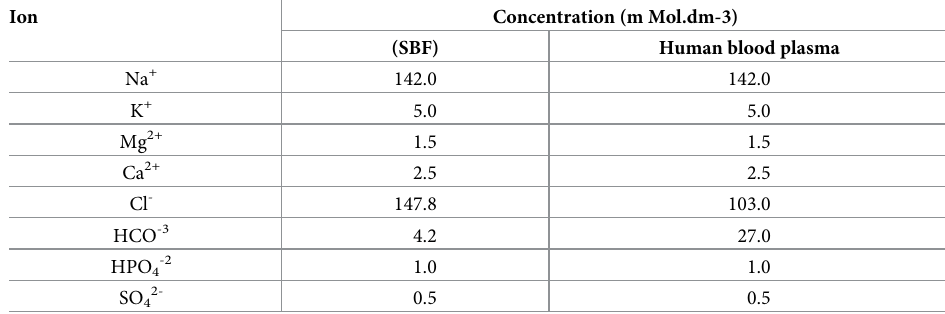
Table 2. Ion concentrations of prepared SBF (Simulated Body Fluid) and human blood